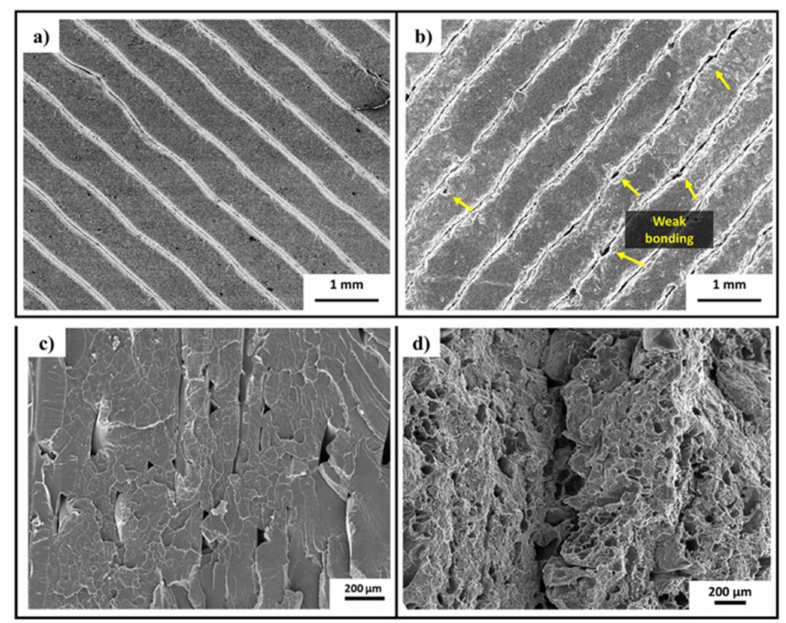
Figure 9. Integration of graphene nanoparticles into FDM 3D-printed PLA. ( a ) Neat PLA after FDM 3D printing. ( b ) PLA / graphene nanocomposite after FDM 3D printing. ( c ) PLA and ( d ) PLA / graphene fractured cross-sectional microstructure. Reproduced with permission from [82], Wiley,